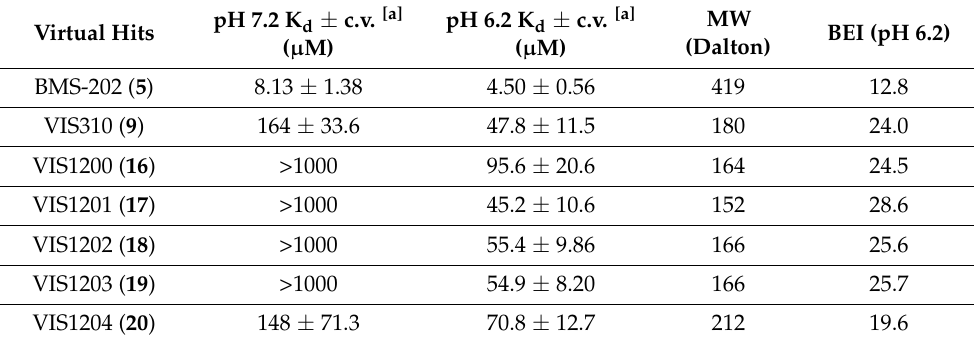
Figure 5. Chemical structures of VIS310 analogues ( 16 – 20 ). Table 2. Dissociation constants (K d ), molecular weight (MW), and binding efficiency index (BEI) of BMS-202 ( 5 ), VIS310 ( 9 ), and analogues 16 – 20 against PD-L1 at pH 6.2 and